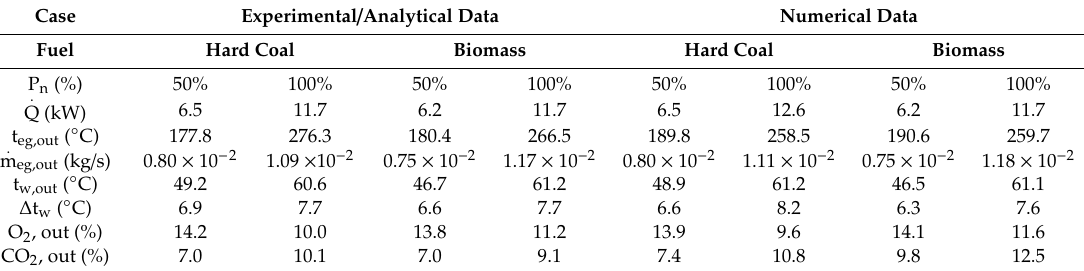
Table 4. Comparison of crucial parameters obtained in numerical and experimental (analytical) part of the research.